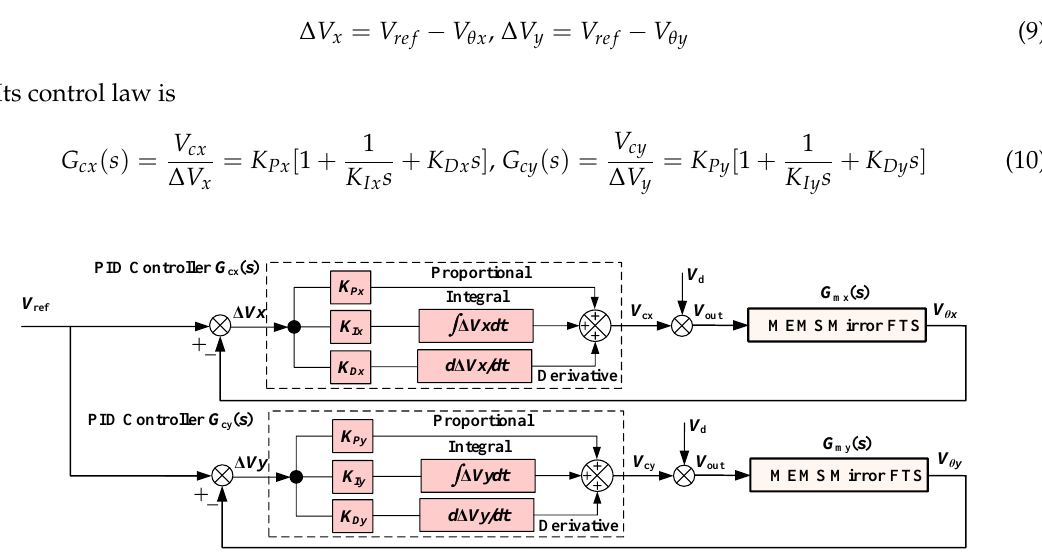
Figure 10. The block diagram of the proposed proportional-integral-derivative (PID) controller.